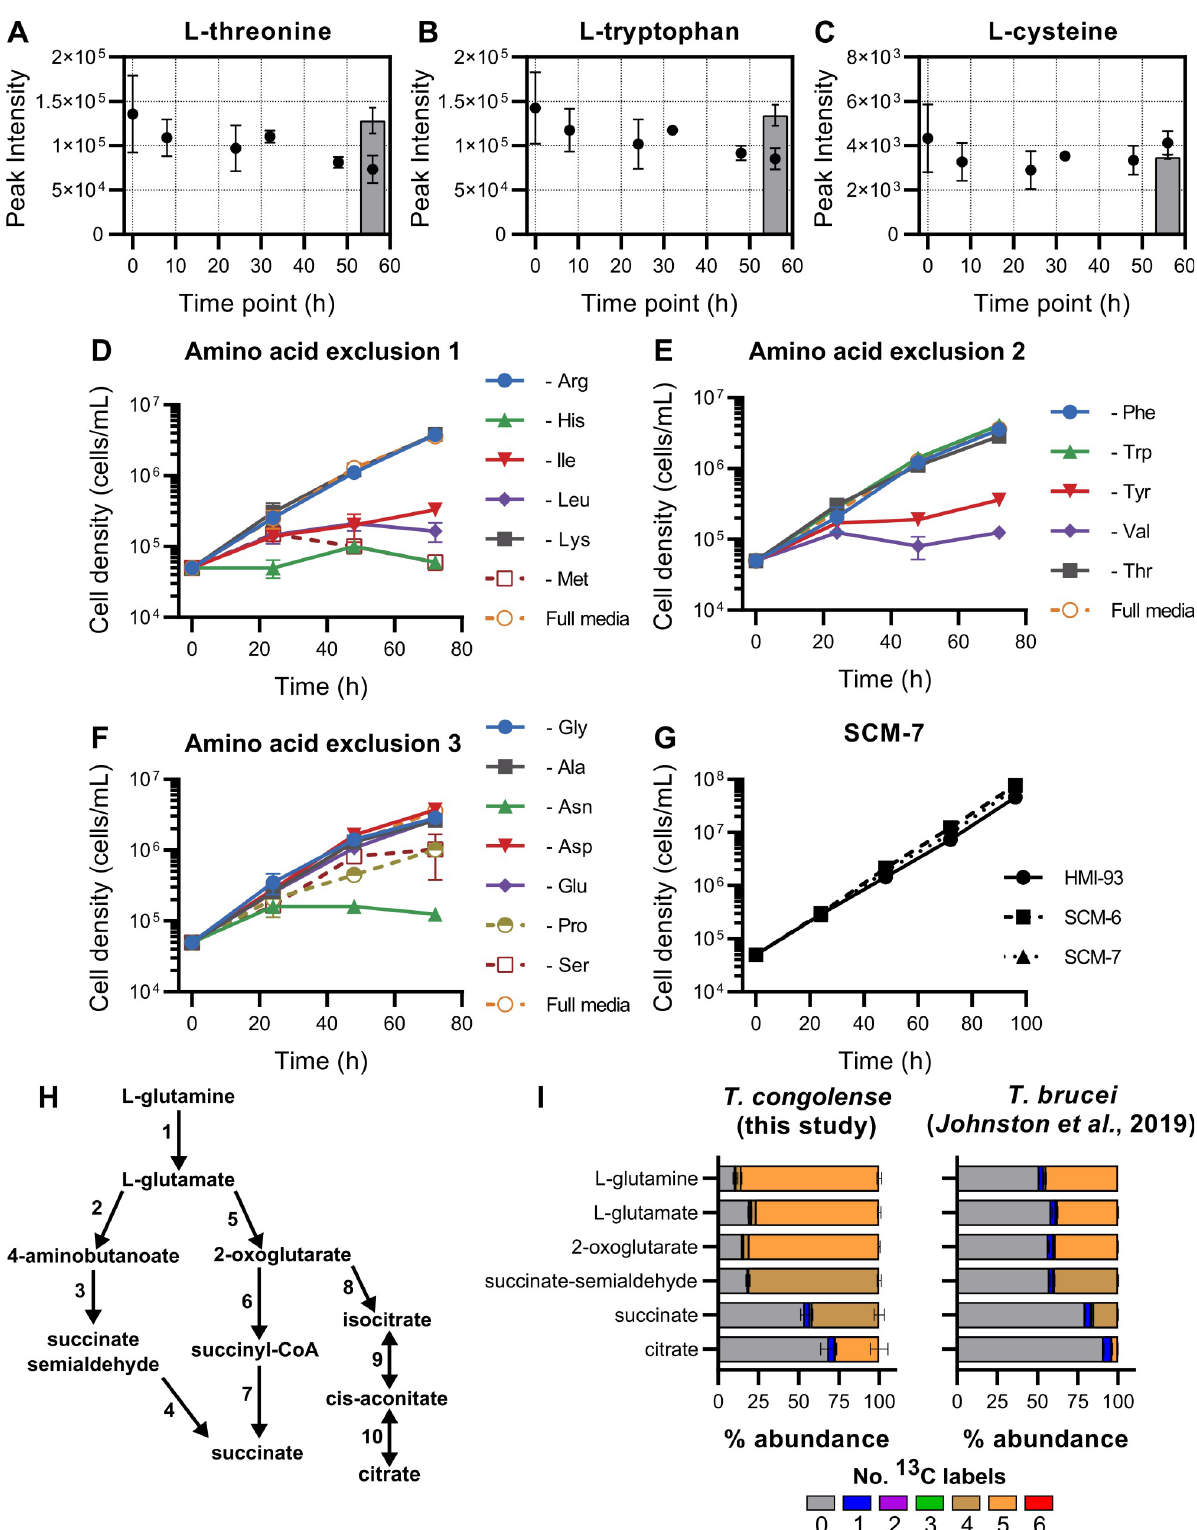
Fig 6. Amino acid metabolism in T . congolense IL3000. A-C) Analysis of indicated amino acids in T . congolense IL3000 culture supernatants over a 56 h time course. Grey bars indicate a negative medium control group. D-F) Growth curves in SCM-6 excluding one amino acid at a time,